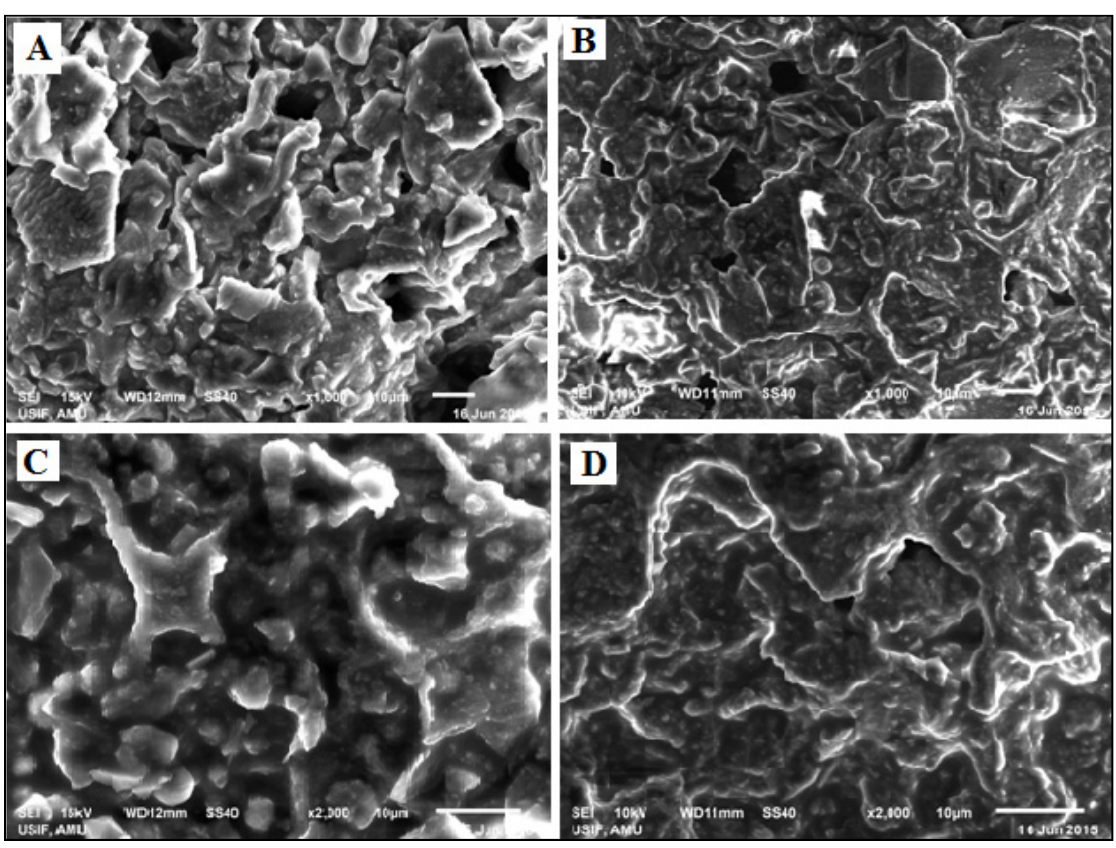
Figure 1. SEM images of T. ammi L. seed biomass: ( A ) before SC ‐ CO 2 , ( B ) after SC ‐ CO 2 at 1000× magnification, and ( C ) before SC ‐ CO 2 , ( D ) after SC ‐ CO 2 at 2000× magnification.